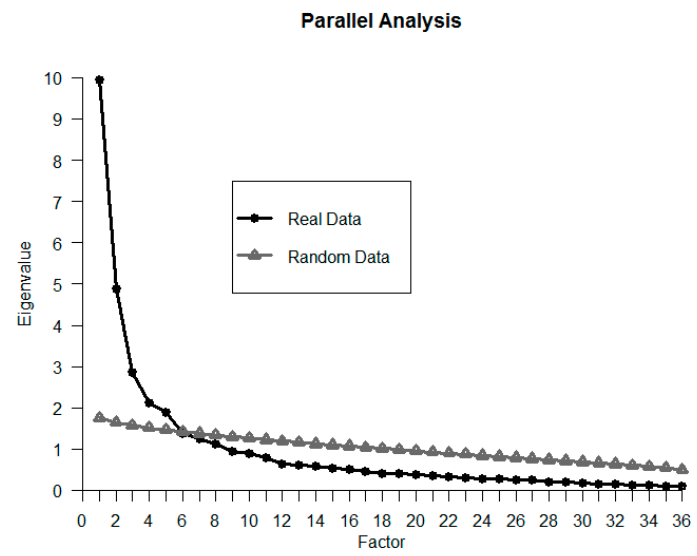
Figure 1. Parallel analysis of the Food Choice Questionnaire (FCQ) responses. Table 1. Goodness of fit indices for the different models.